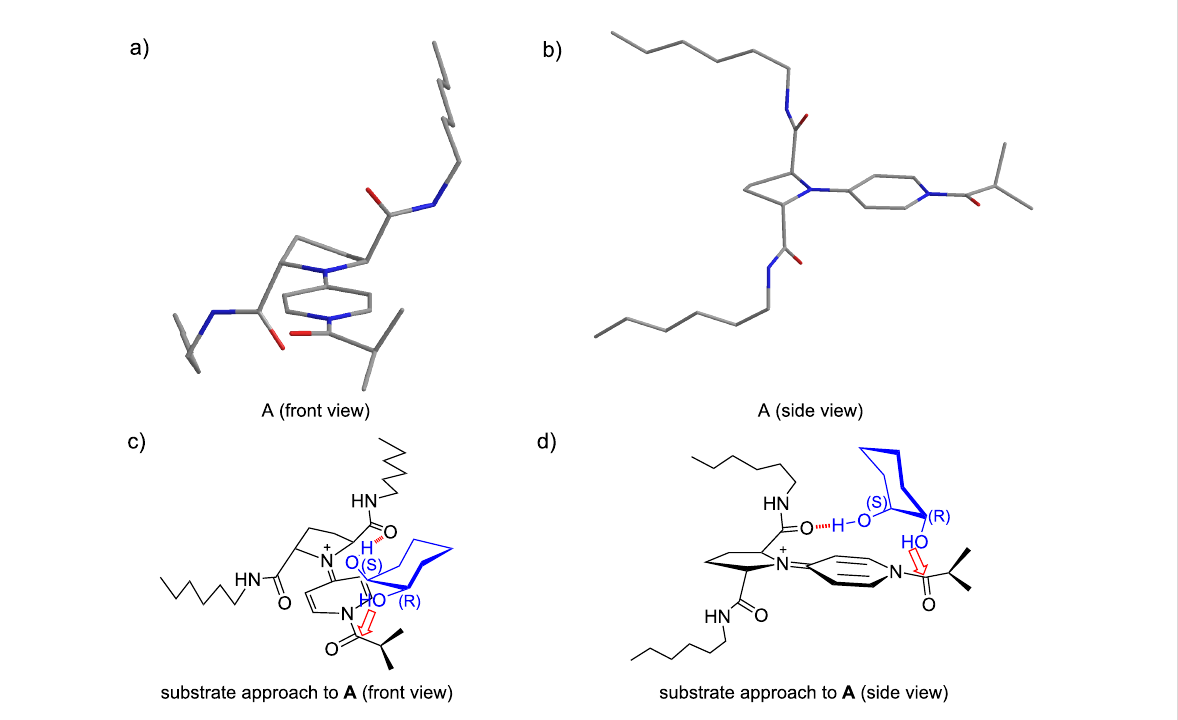
Figure 2: A hypothetical model for the transition-state assembly of the asymmetric acylation of 5 promoted by catalyst 11 . Front view a) and side view b) of the calculated structure of acylpyridinium ion A . Front view c) and side view d) of the possible modes for the substrate approach to A